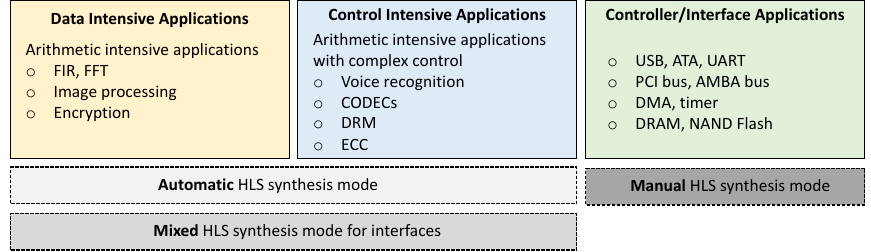
Figure 6. Application types and different HLS synthesis